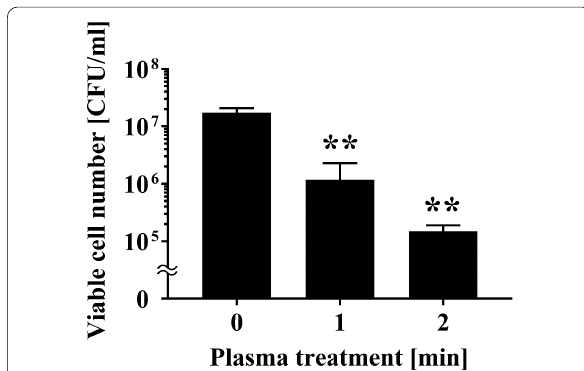
Fig. 1 Viable cell number of P. venetum on an aluminium plate following APDBD treatment. The viable cell number of P. venetum on the contaminated aluminium plate at each individual APDBD treatment time (0, 1, or 2 min) is expressed as colony forming units (CFU) per ml. Differences where p < 0.01(**) versus control (0 min) were considered significant when verified by the non-repeated measured ANOVA followed by the Bonferroni correction